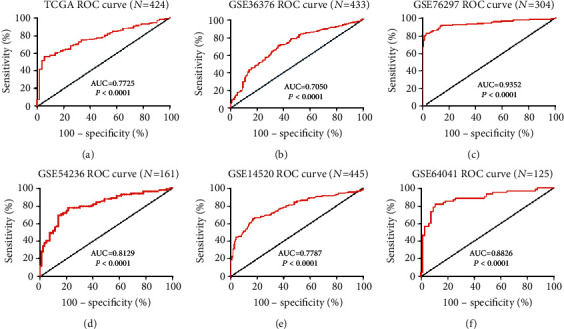
ROC curve analysis of UGP2 expression in HCC. (a–f) ROC curve analysis of UGP2 expression in HCC from the TCGA, GSE36376, GSE76297, GSE54236, GSE14520, and GSE64041 datasets. UGP2: uridine diphosphate-glucose pyrophosphorylase 2; TCGA: The Cancer Genome Atlas; HCC: hepatocellular carcinoma; ROC: receiver operating characteristic.